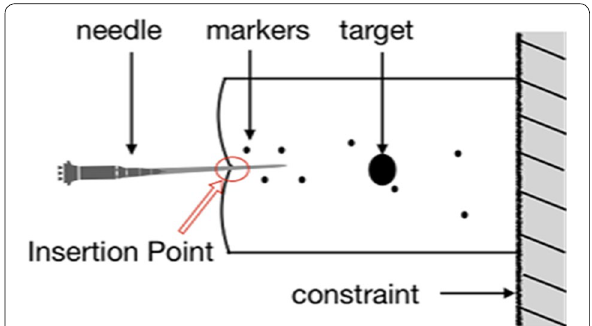
Figure 1 Needle insertion into the phantom in the center of one side